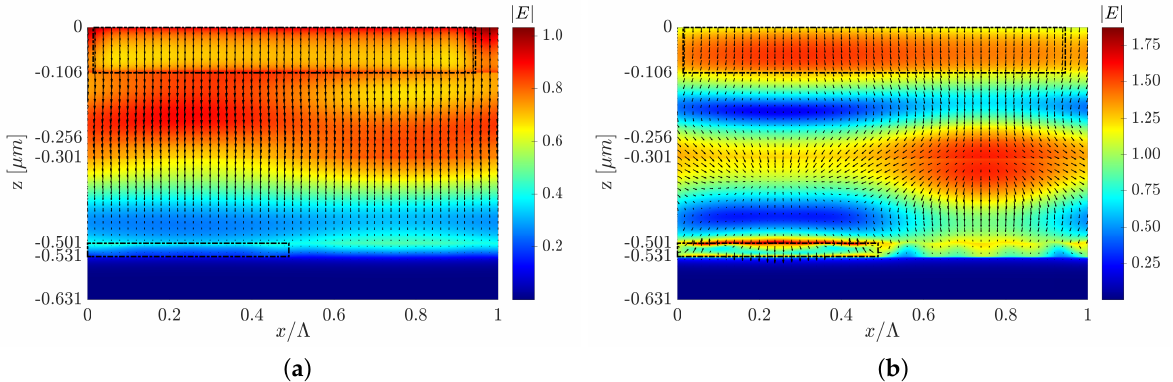
Figure 8. Electric field intensity and quiver plot of the Poynting vector of structure C 1 at ( a ) λ = 600 nm and ( b ) λ = 650 nm, where the y cross-section is at the center of the P3HT:PCBM grating